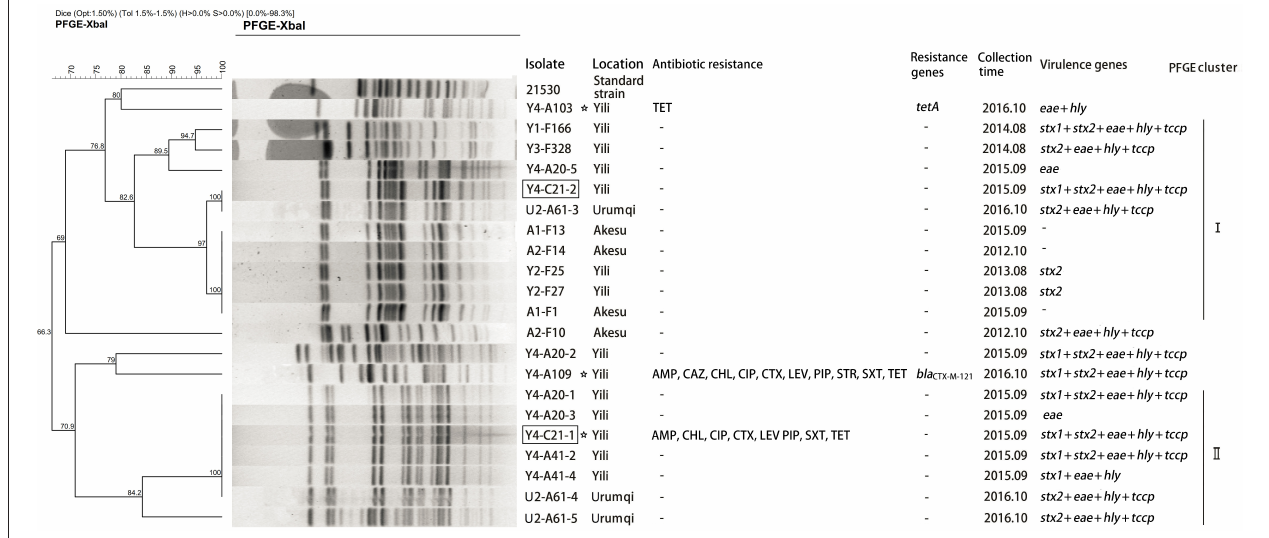
FIGURE 1 | Dendrogram of Xb al pulsed-field gel electrophoresis profiles of E. coli O157:H7 isolates. The box indicates that the strains isolated from slaughterhouse. The asterisk represents the resistant